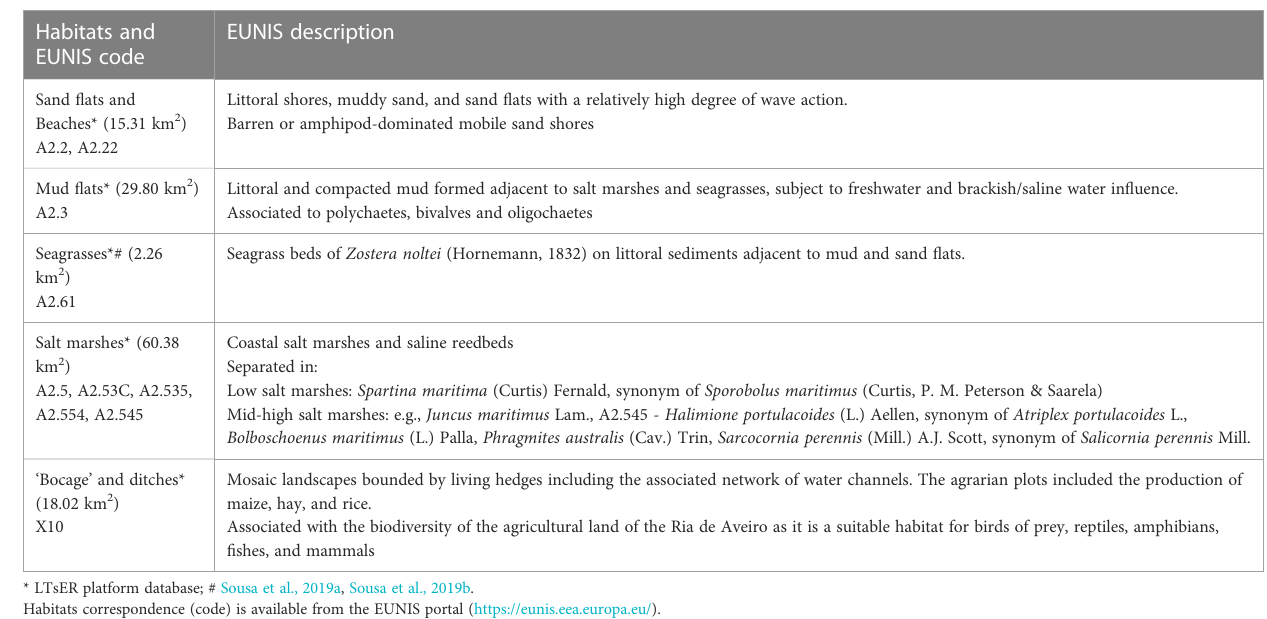
TABLE 1 Description of the habitats evaluated by this study, with respective occupied areas, in square kilometres, at Ria de Aveiro (Portugal). Habitats